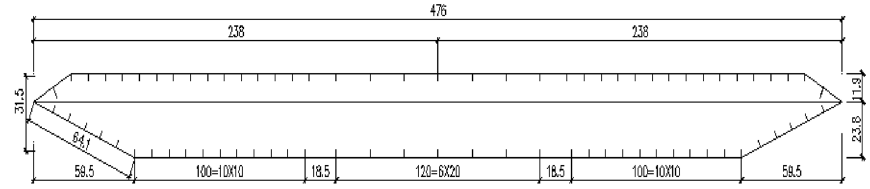
Fig. 13 Cross section of the model and pressure tube arrangement (unit: